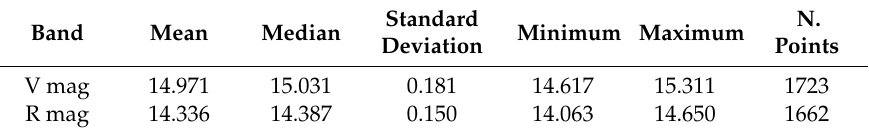
Table 5. The values are shown—mean, median, standard deviation, maximum, minimum and number of data points, for observations of 3C 371 in the time interval 7 September 2019–30 January 2020, on the AZT-3 telescope, Mayaki observatory (Ukraine).